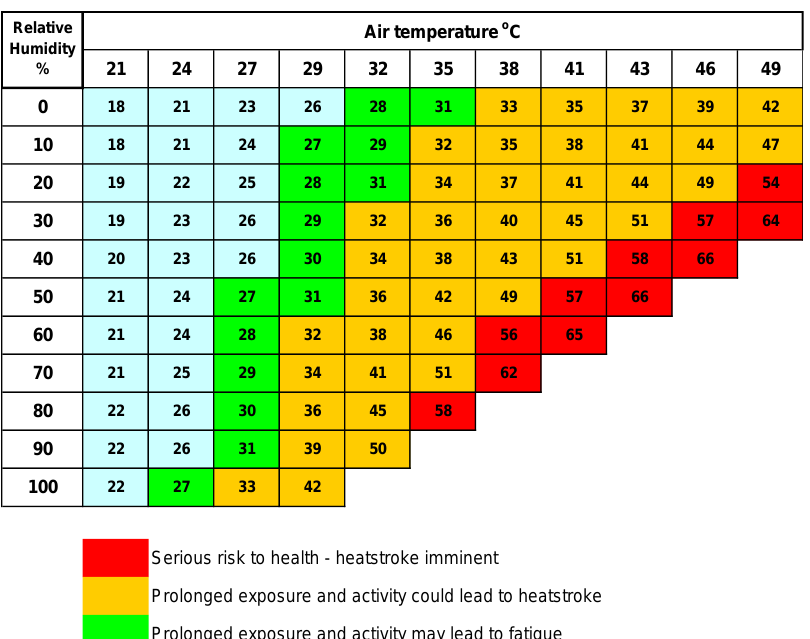
Figure 11. Apparent temperature (heat index) in degrees Celsius according to air temperature and relative humidity [16].